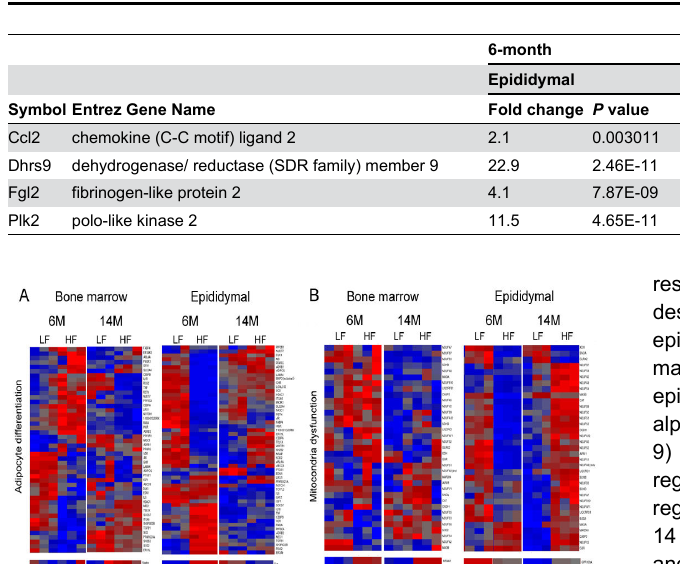
Table 8. Genes altered by a high fat diet in each adipose depot at each